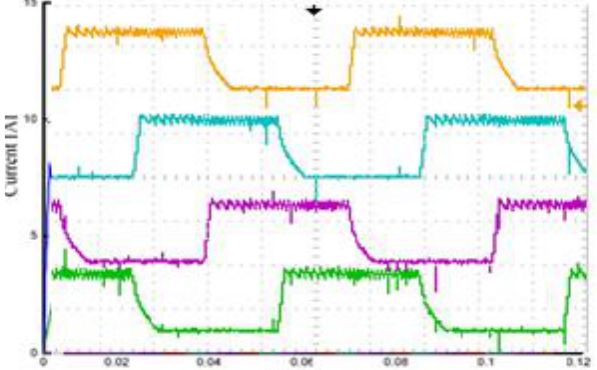
Fig. 11. Phase torque waveform of 4-phase machine including the control i.e., voltage PWM